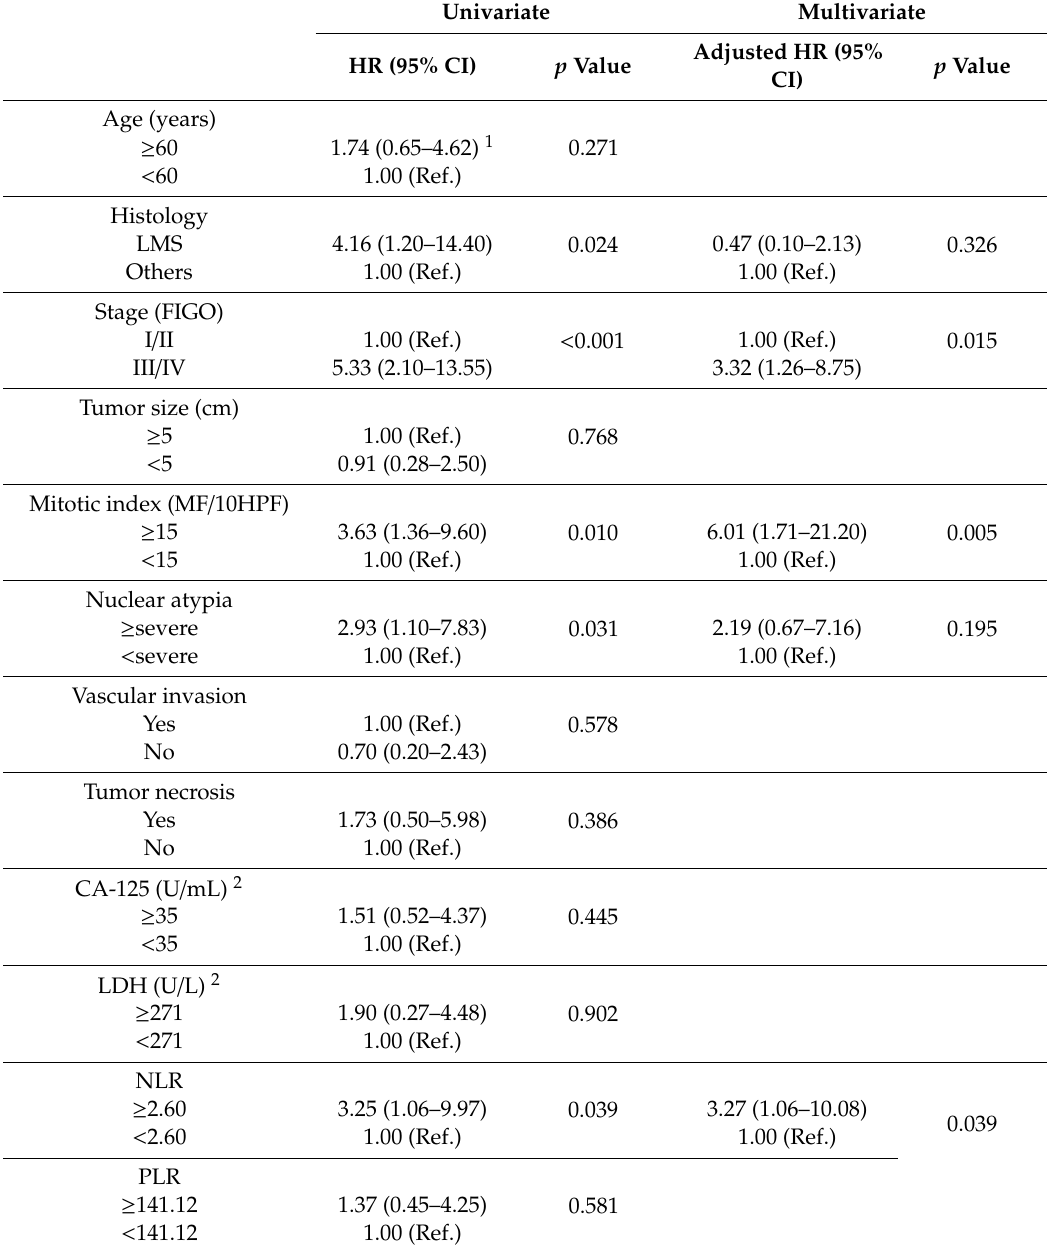
Table 3. Univariate and multivariate analysis of prognostic factors for overall survival ( n =